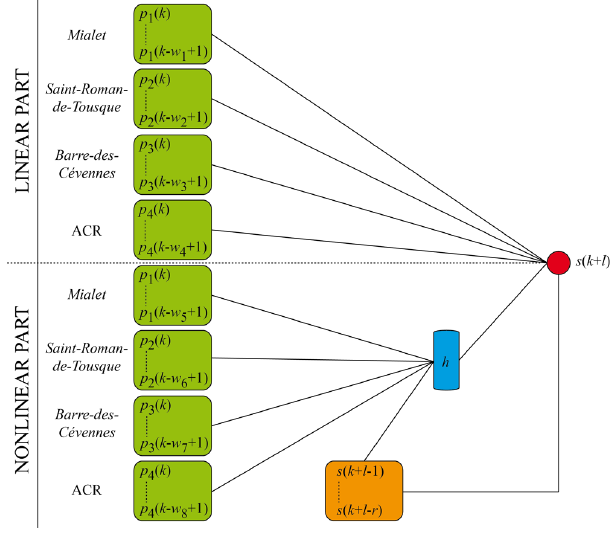
Fig. 7. Recurrent model. Green elements are rain gauge input vari- ables, orange elements are recurrent input variables (noted s) , blue element represents hidden layer and red circle represent the linear output neuron. ACR represents the average cumulative rainfall; p n refers to the rainfall (instantaneous or cumulative) value and w i to the length of the respective sliding window. l is the forecast lead time. The sliding window of previous estimated discharges is r : the order of the mode. The number of neurons on the hidden layer is h